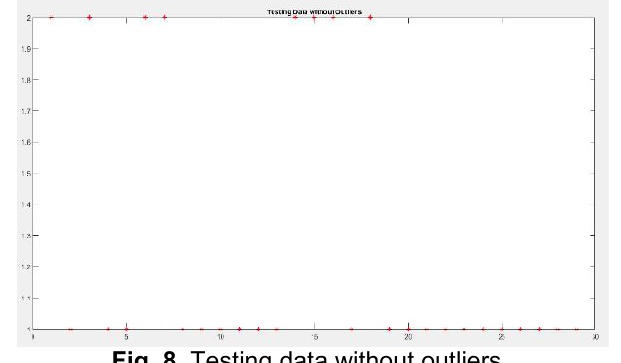
Fig. 8. Testing data without outliers Fig. 8 represents test data set after the removal of outliers. 27 patient’s data is used again as a test input for the given data